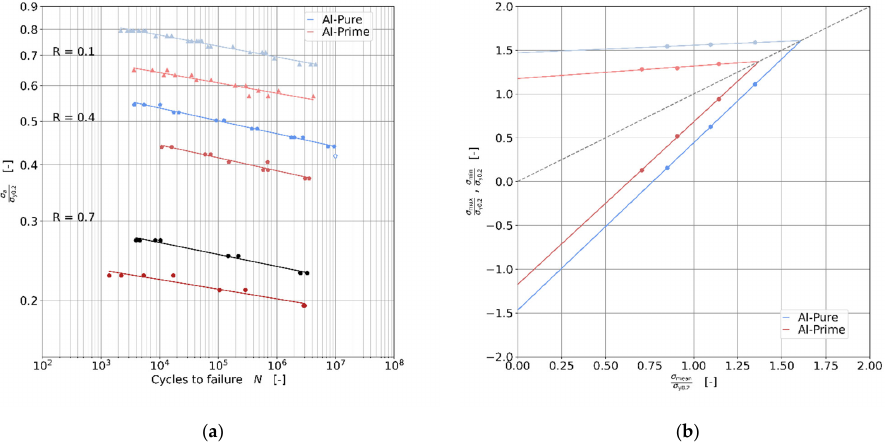
Figure 6. Wöhler diagram scaled to the initial yield stress σ y0.2 of each wire material ( a ), Smith diagram scaled to initial yield stress σ y0.2 of each wire material ( b ).